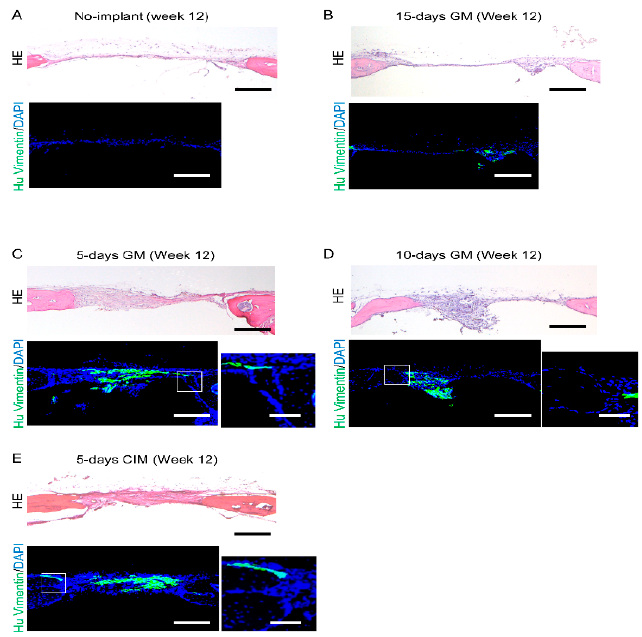
Figure 4. Transplantation of C-MSCs cultured with XF-GM for 5 or 10 days, or XF-CIM for 5 days slightly induces host new bone formation. ( A – E ) Animals were sacrificed at 12 weeks after surgery and the cranial bones were isolated. Semi-serial sections (8 µ m) were obtained and stained with HE and immunostained with anti-human vimentin antibody, as indicated. Nuclei were counterstained with DAPI for immunostaining. HE and left panels of immunostaining images show lower magnification, Bar = 250 µ m. Right panels of immunostaining indicate higher magnification, Bar = 50 µ m. ( A ) No implant. ( B ) 15-days GM: transplantation of C-MSCs cultured in XF-GM for 15 days. ( C ) 5-days GM: transplantation of C-MSCs cultured in XF-GM for 5 days. ( D )